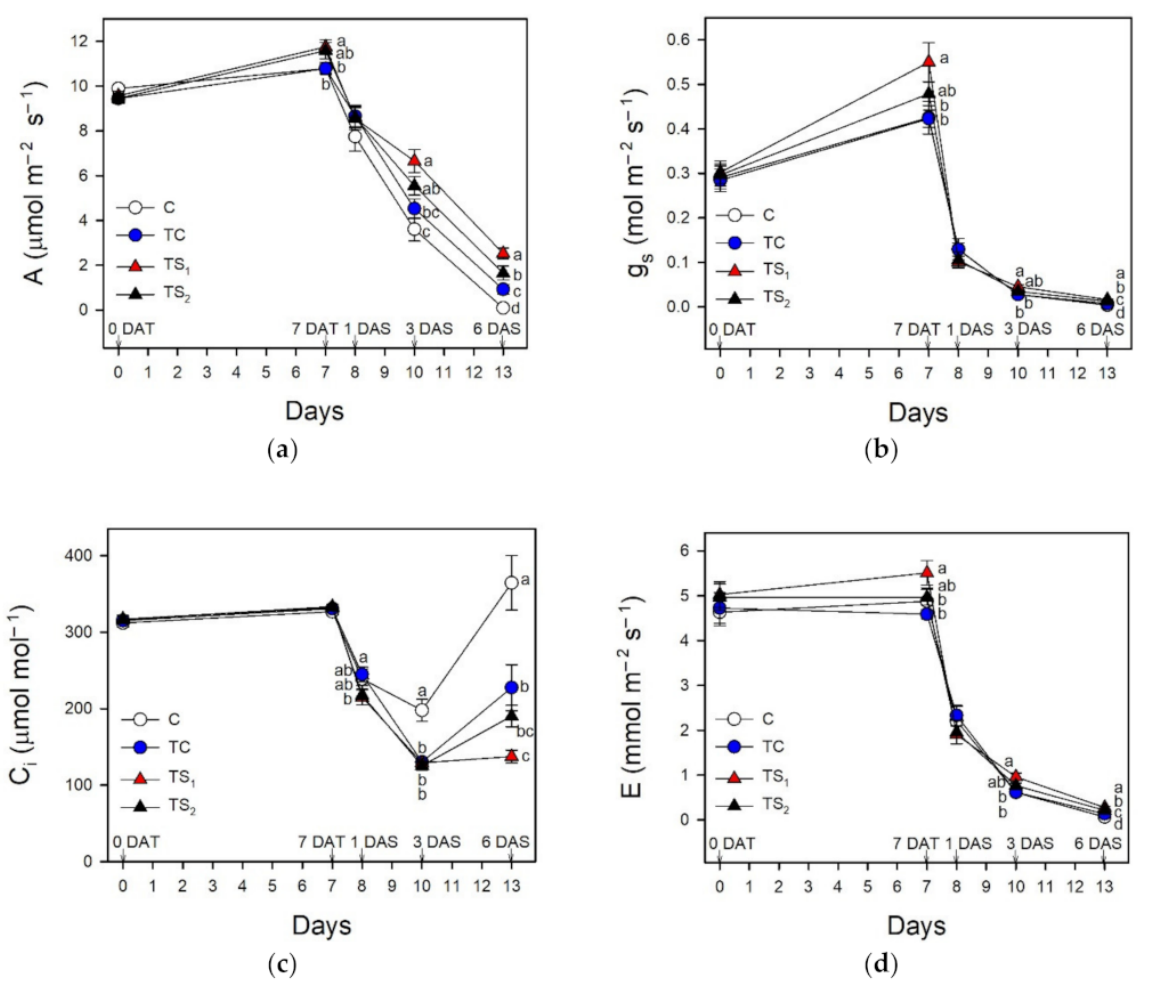
Figure 6. Gas exchange measurements in leaves of purple basil cv. Red Rubin at 0 and 7 days after bacterial treatment (0 DAT and 7 DAT, respectively) and at 1, 3, and 6 days after water stress (1 DAS, 3 DAS, and 6 DAS, respectively): ( a ) steady state photosynthetic CO 2 assimilation rate (A); ( b ) stomatal conductance (g s ); ( c ) intercellular CO 2 concentration (Ci); ( d ) transpiration rate (E). Values are means ± SE ( n = 10). Different letters indicate significant differences among bacterial treatments and control (one-way ANOVA with Fisher’s LSD test, p ≤